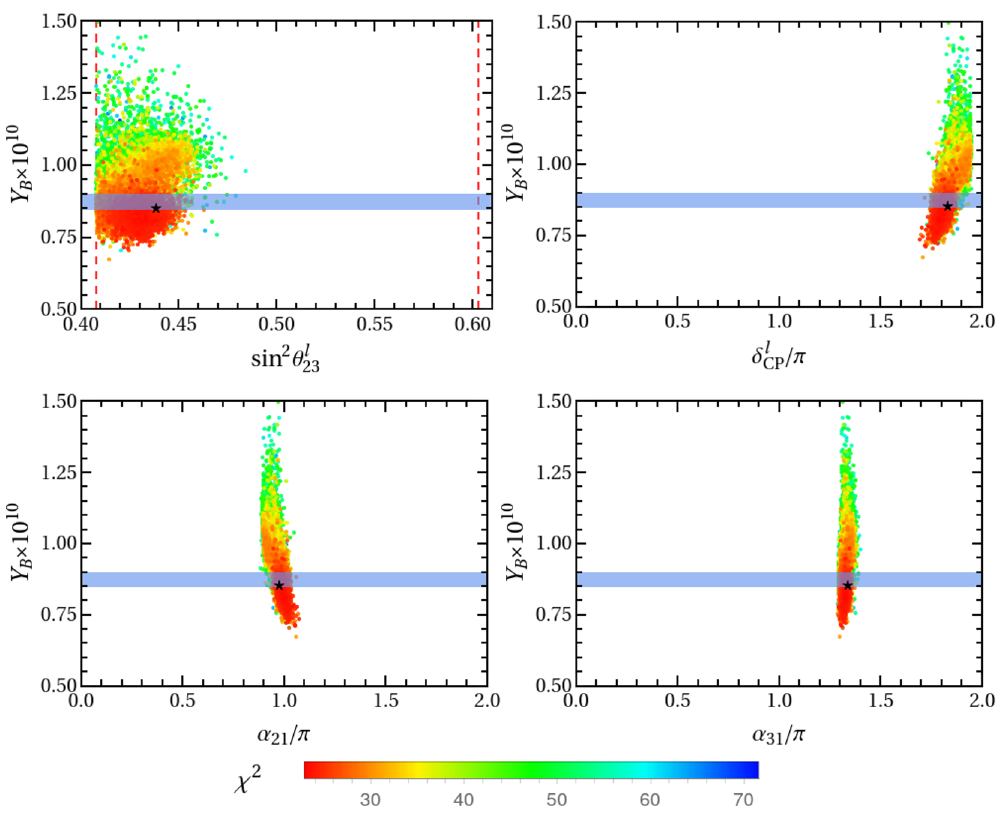
Figure 7 . The numerical results for the correlation between the baryon asymmetry Y B and sin 2 θ l δ l , α 21 , α 31 in the BM1 model with thermal initial condition. The horizontal band denotes the CP experimentally allowed region of Y B . The star “ F ” stands for the best fitting point in table 4. Note that the contribution of Y B to χ 2 is not included